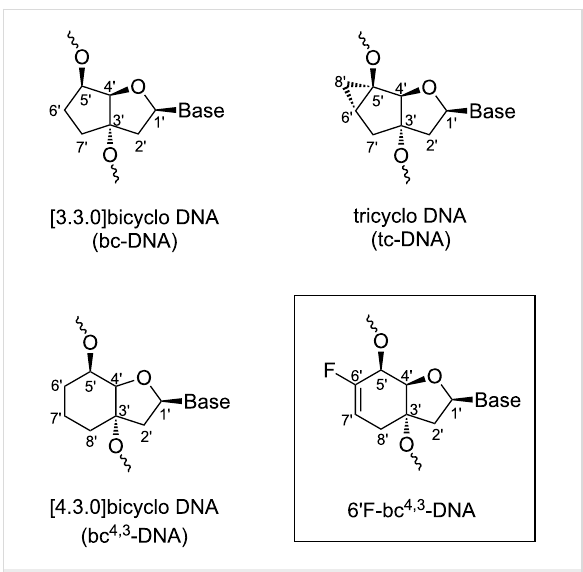
Figure 1: Chemical structure of selected nucleic acid